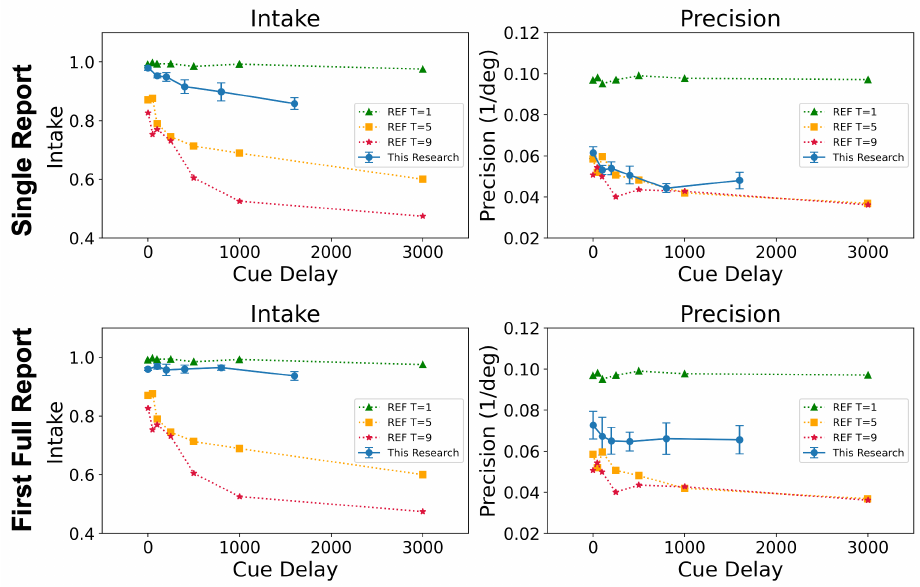
Figure 6. Intake ( left column ) and precision ( right column ) as a function of cue delay. Error bars represent ±SEM. Solid curves are from the current study (target set size = 3). The dotted curves (the target set sizes were set to 1, 5, and 9) are from Ö˘gmen et al. [21], abbreviated as REF in the inset for